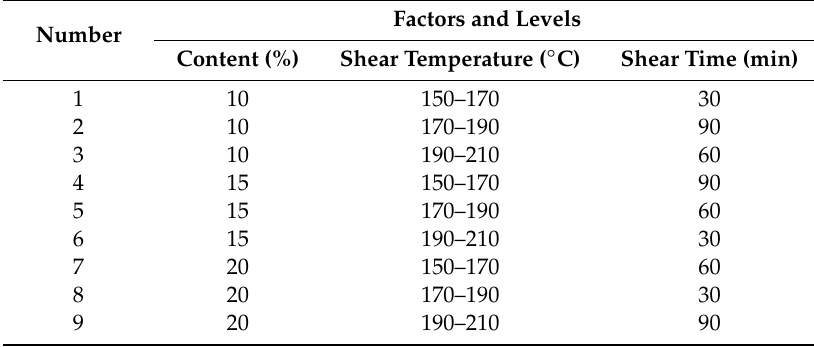
Table 3. Schemes of orthogonal